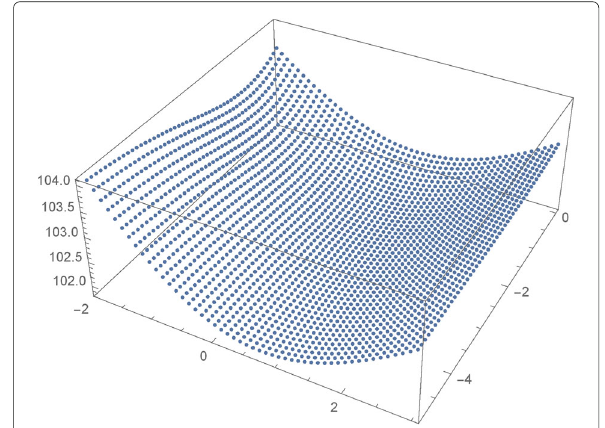
Fig. 1 Expectation value of the procurement cost E [ C ]. This figure is a 3D plot of the expectation value of the procurement cost E [ C